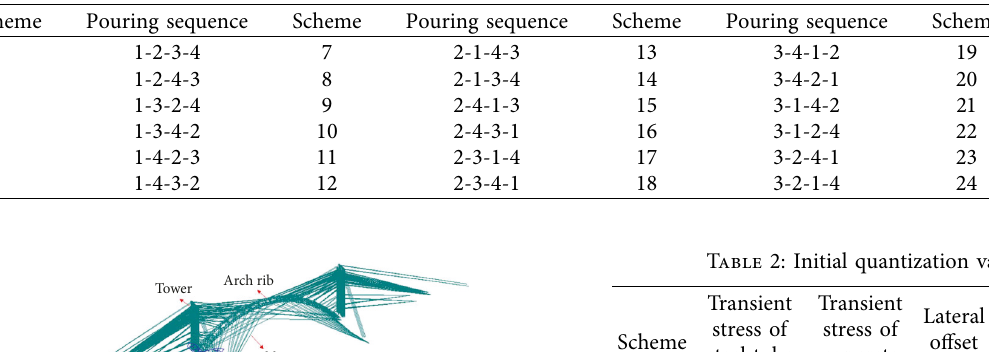
Figure 2: Cross-section of the arch rib. Table 1: 24 pouring schemes.